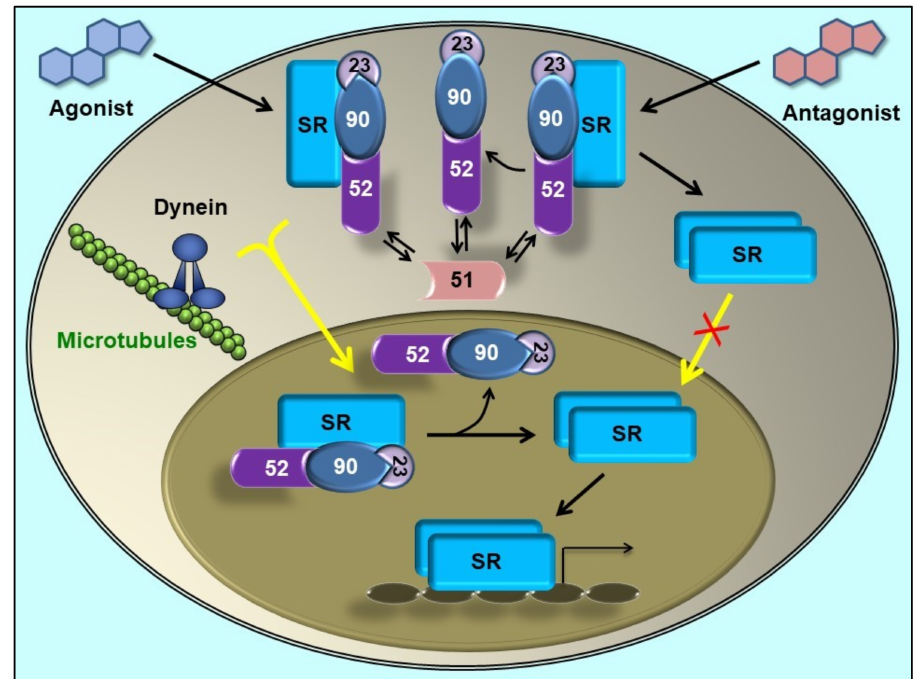
Figure 2. Steroid receptor (SR) retrotransport is affected by immunophilins. The mature form of SR forms complexes with a dimer of Hsp90, one molecule of Hsp70 (not depicted in this figure), the co-chaperone p23, and one TPR-domain immunophilin [51]. FKBP51 (unable to interact with dynein [18]) is associated to the empty SR. When the steroid binds, FKBP51 is exchanged by FKBP52 due to a ligand-induced conformational change of the receptor [52]. In turn, FKBP52 recruits the dynein-dynactin motor complex to its PPIase domain [41]. The complex is rapidly (T 0.5 = 5 min) transported to the nucleus on cytoskeleton tracks. SR ‘ transformation ’ (i.e. the dissociation of the Hsp90-based complex) is a nuclear event [42]. Some antagonists can promote the release of Hsp90 in the cytoplasm, such that SR does not reach the nucleus [50]. Note that regardless of the SR primary localization, they are constantly cycling between the nuclear and cytoplasmic subcellular compartments [45,53], even when the final equilibrium may be displaced to a given cell compartment. When the steroid promotes the full nuclear accumulation of the SR, it still cycles. The disruption of the “transportosome” by any means (Hsp90-disrupting drugs, dynein inhibitors, overexpression of the PPIase or TPR domain, ATP depletion, low temperature, etc.) does not prevent SR movement, but it is one order of magnitude slower (T 0.5 = 45–60 min) than the active mechanism. It is thought that this residual movement represents the diffusion of the complex through the crowded